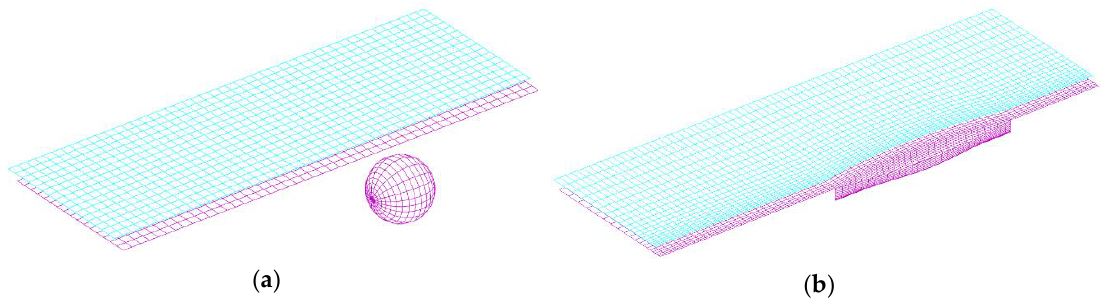
Figure 3. Typical panel arrangements of ( a ) submerged sphere and ( b ) Wigley I ship.